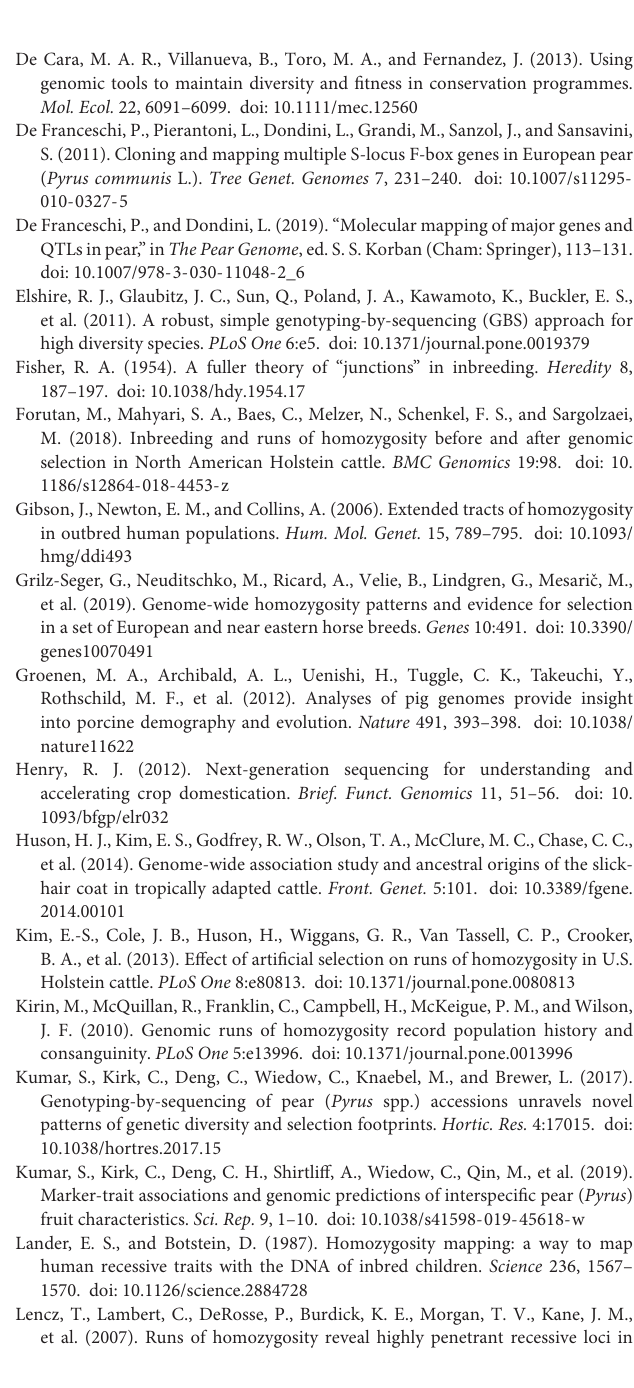
Supplementary Figure S2 | Population structure of Asian, European and inter-specific hybrid pear accessions using principal components analysis (PCA). Supplementary Figure S3 | Distribution of the runs of homozygosity (ROH) across different linkage groups in Asian, European and Hybrid pear ( Pyrus spp.) accessions. Supplementary Figure S4 | The frequency (%) of single nucleotide polymorphisms (SNPs) occurrence into runs of homozygosity (ROH) islands within the Asian, European and hybrid pear ( Pyrus spp.) population. The blue and red color represent chromosomes.